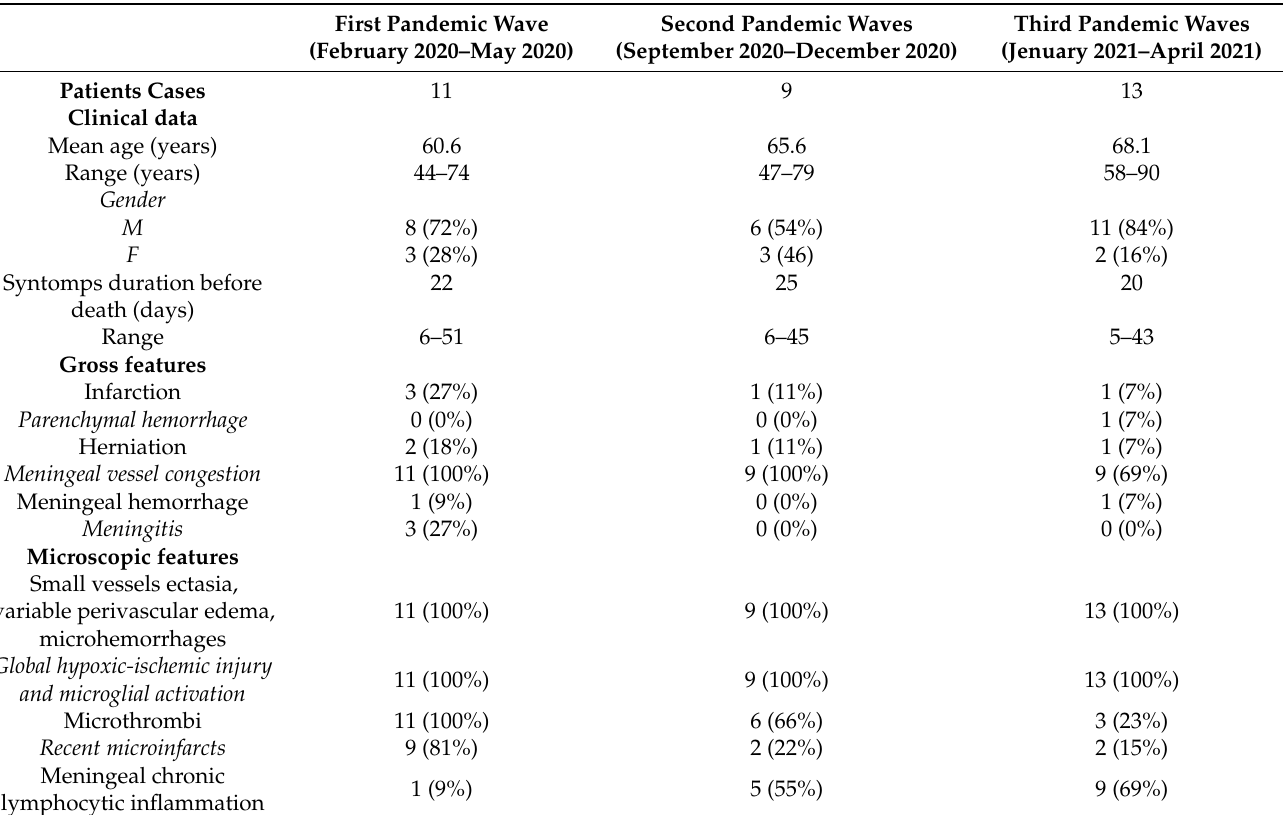
Table 1. Summary of findings in the three pandemic